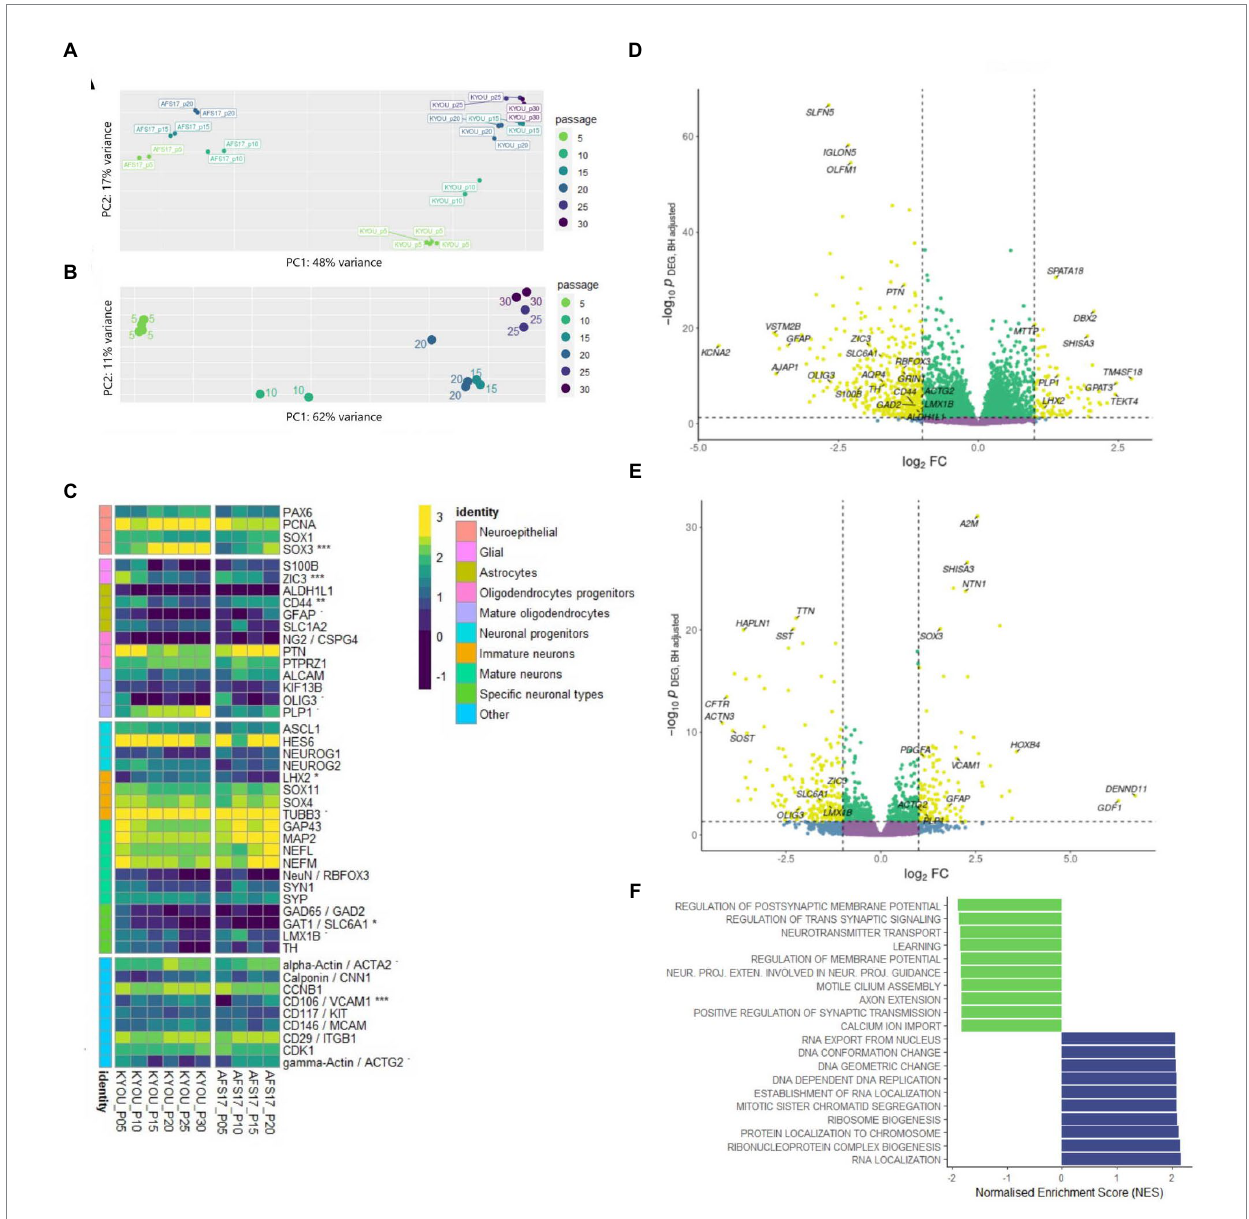
FIGURE 5 Bulk transcriptome analysis. (A) Principal component analysis applied to variance stabilized transformed expression data for both N-KYOU and N-ASF17 cultures. (B) Principal component analysis applied to variance stabilized transformed expression data for N-KYOU cultures. (C) Heatmap of change of expression in selected cell markers across passages for both N-KYOU and N-ASF17 cultures. Showing only genes that reached conventional statistical significance in DE analysis (“*” – p < 0.001; “**” – p < 1e-04; “***” – p < 1e-05). Color is transcripts per million (TPM) from highest (yellow) to lowest (blue) for each gene across the passages. The colored bar on the left indicates the functional annotation for a particular marker. The “Specific neuronal types” group includes markers of fully differentiated neurons: GAD65 and SLC6A1 for gabaergic, and LMX1B and TH for dopaminergic. The “Other” group includes markers for proliferating, stromal, endothelial or vascular cells. (D,E) Volcano plots of differentially expressed genes related to passage in the N-KYOU and N-ASF17 culture, respectively. Each dot represents a gene in coordinates of effect, log 2 (fold change of expression at 30 passages vs. 5 passages) vs. statistical significance, − log 10 ( value of p , BH adjusted). Yellow dots correspond to genes whose expression changes both abs(FC) > 2 and value of p <0.05. The yellow quadrants contain marked specific genes with high expression differences or significance, and known cell type markers The marker genes are LHX2 (immature neurons), RBFOX3 (NeuN) (mature neurons), GRIN1 (glutamatergic neurons), TH (dopaminergic neurons), GAD2 and SLC6A1 (gabaergic neurons), ALDH1L1, AQP4, CD44, GFAP and S100B (glial), PTN (oligodendrocyte progenitors) , PLP1 and OLIG3 (mature oligodendrocytes), and ACTG2 (vascular smooth muscle cells). (F) Results of gene set enrichment analysis (GSEA) for N-KYOU. The figure shows the top 10 depleted (green) and top 10 enriched (blue) GO BP terms sorted by normalized enrichment score (NES). All depicted terms reached statistical significance with p < 0.05